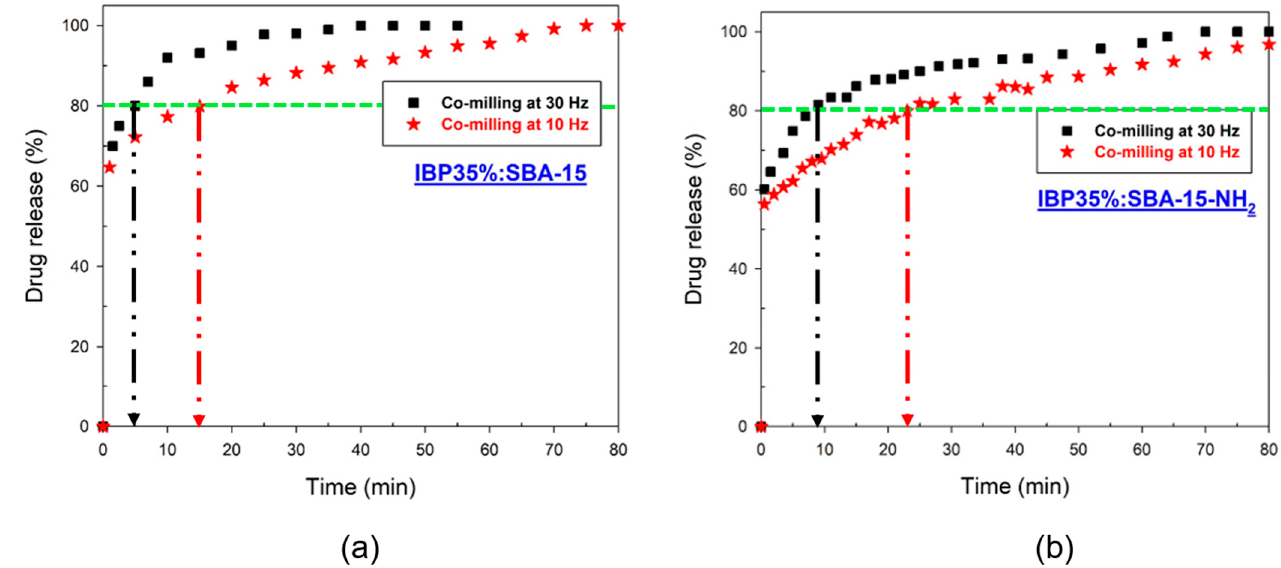
Figure 10. Release profiles of IBP ( a ) from SBA-15; ( b ) from SBA-15-NH 2 .